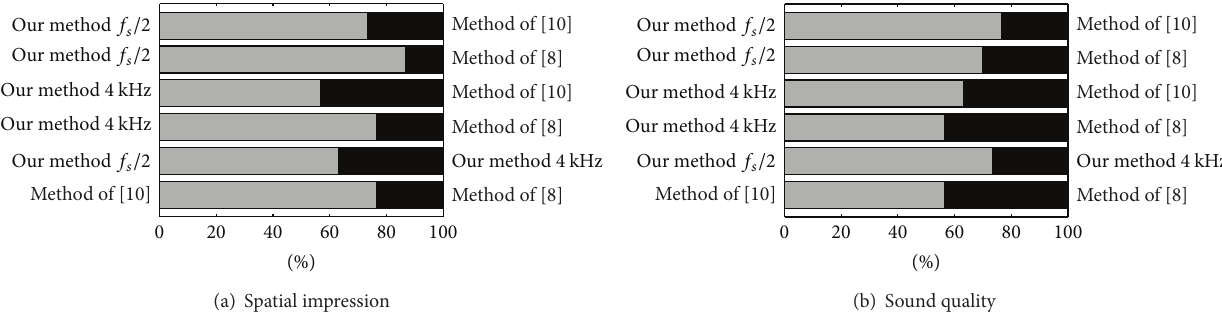
Figure 17: Overall results for the preference listening test for binaural